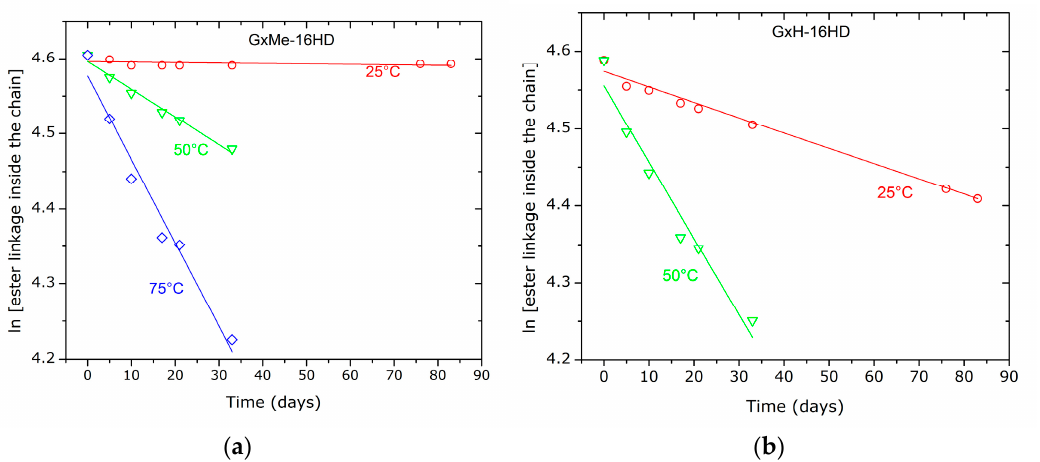
Figure 11. First order fit of the hydrolytic degradation GxMe-16HD and GxH-16HD samples as consequence of the treatment with citric acid 5% at 25, 50, respectively, 75 °C.